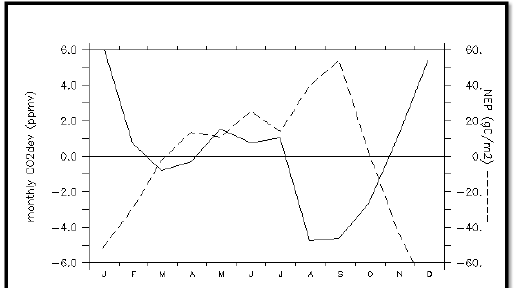
. Figure 7: Comparison between monthly observed CO 2 and simulated net ecosystem productivity during